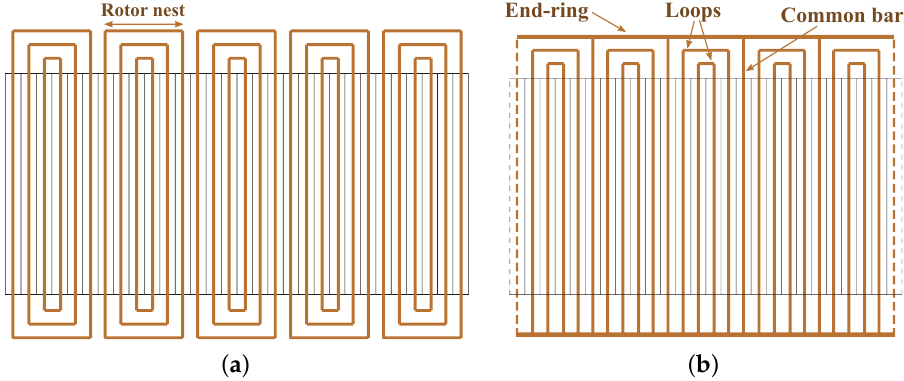
Figure 5. Broadway & Burbridge rotor winding arrangements: ( a ) Graded winding rotor and ( b ) multicircuit winding rotor [18].